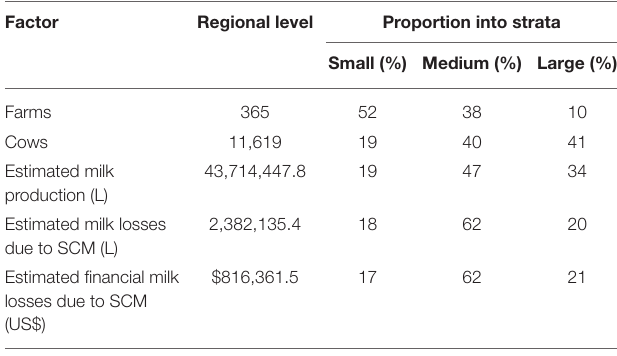
TABLE 5 | Regional and strata losses estimation per year, calculated for each stratum in Area Five, Bogota Plateau.